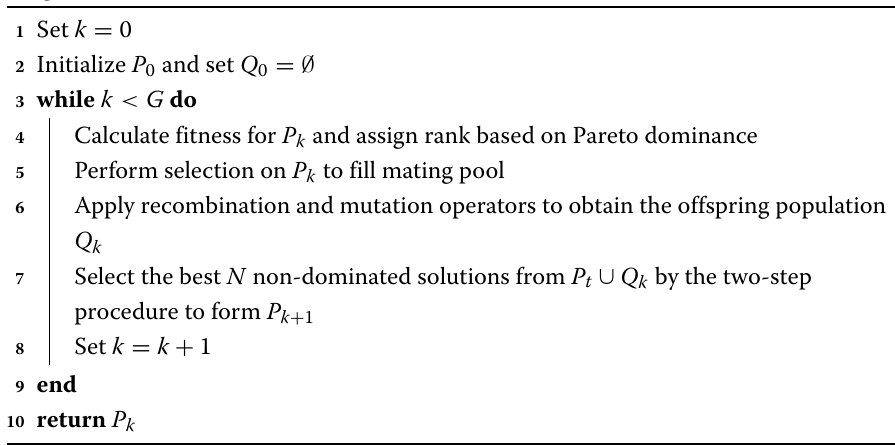
Algorithm 1: NSGA-II (Deb et al.